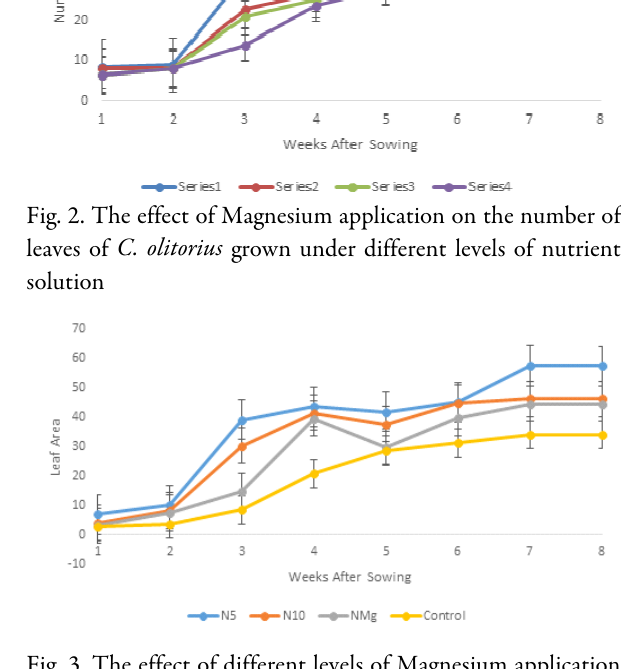
Fig. 3. The effect of different levels of Magnesium application on the leaf area of C.